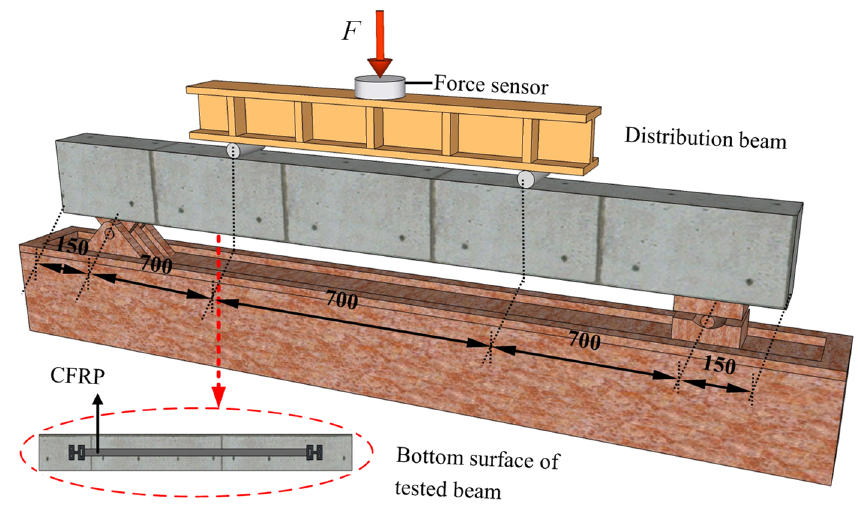
Figure 4. The simplified model of experimental RC beam and loading apparatus.